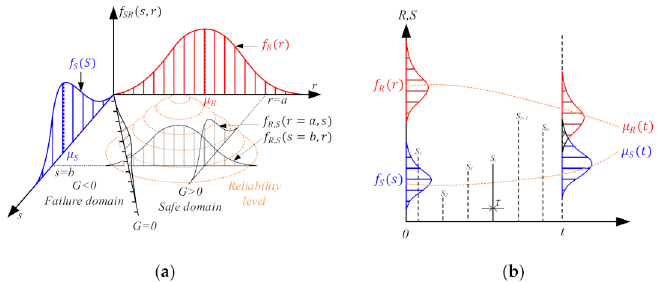
Figure 2. Illustration of the reliability analysis for basic random variables; ( a ) time-invariant model; ( b ) time-variant